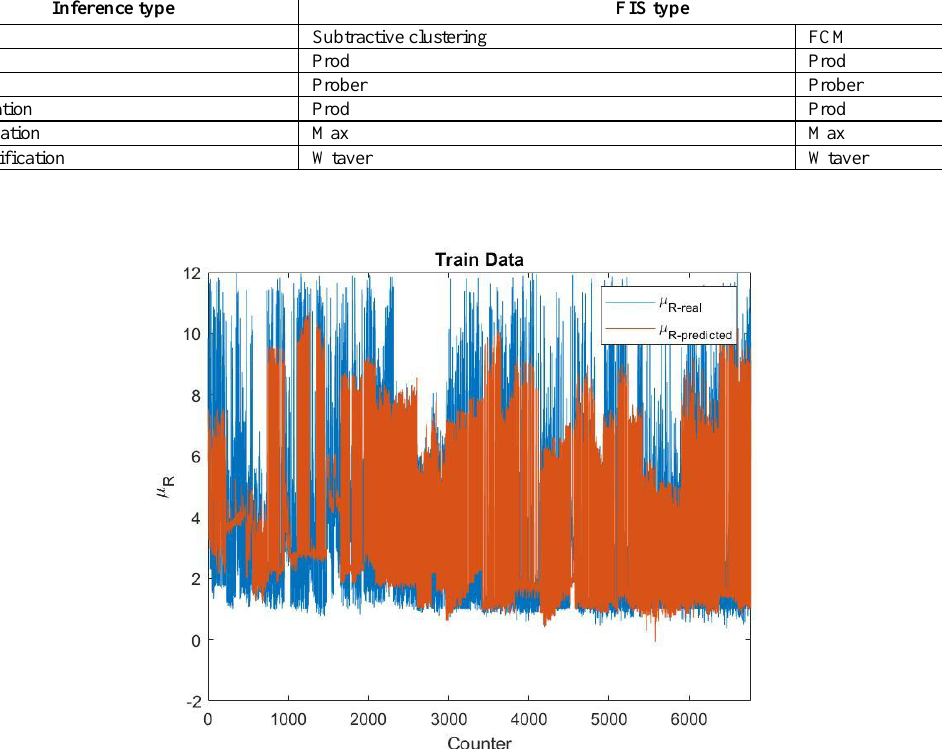
Figure 9. Comparison between the real and predicted value of ( μ R ) in training data (Subtractive clustering